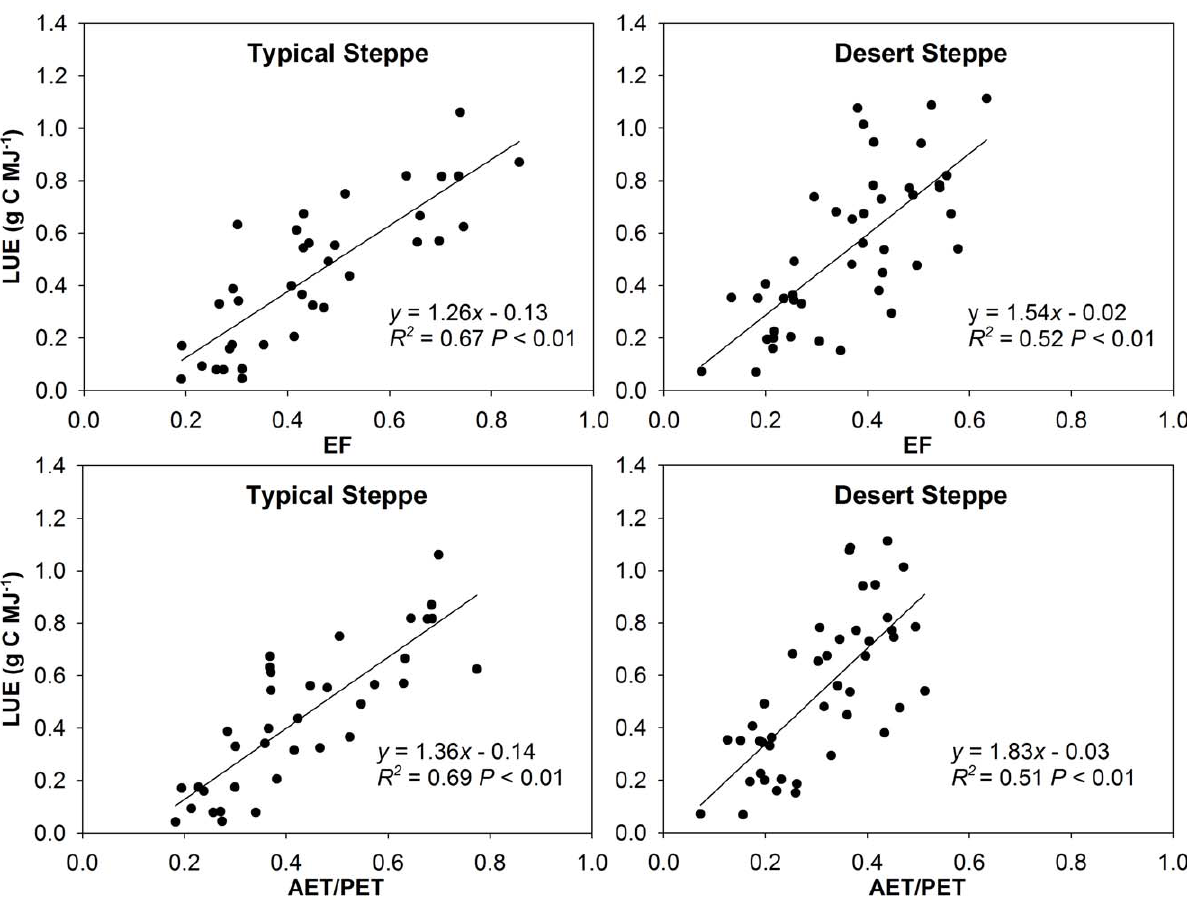
Figure 5. Relationships between light use efficiency (LUE) and EF and AET/PET at the two sites. EF (evaporative fraction) is ratio of latent heat flux to available energy (LE + H); AET/PET is ratio of actual evapotranspiration to potential evapotranspiration, calculated using the Penman- Monteith equation.